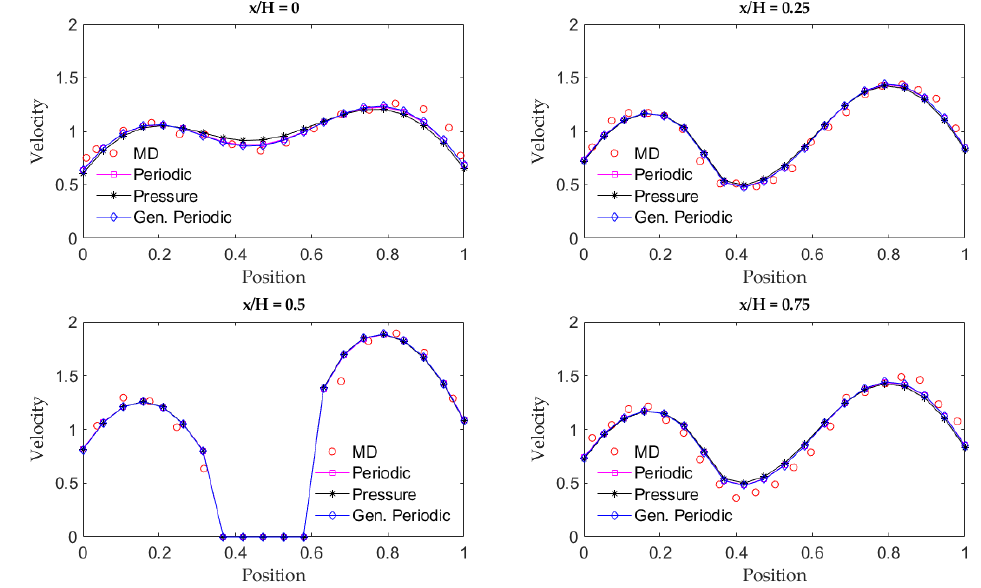
Figure 10. Velocity profiles by LB with three inlet–outlet treatments at different cross sections. Y axis represents normalized streamwise velocity, and X axis represents the position across the